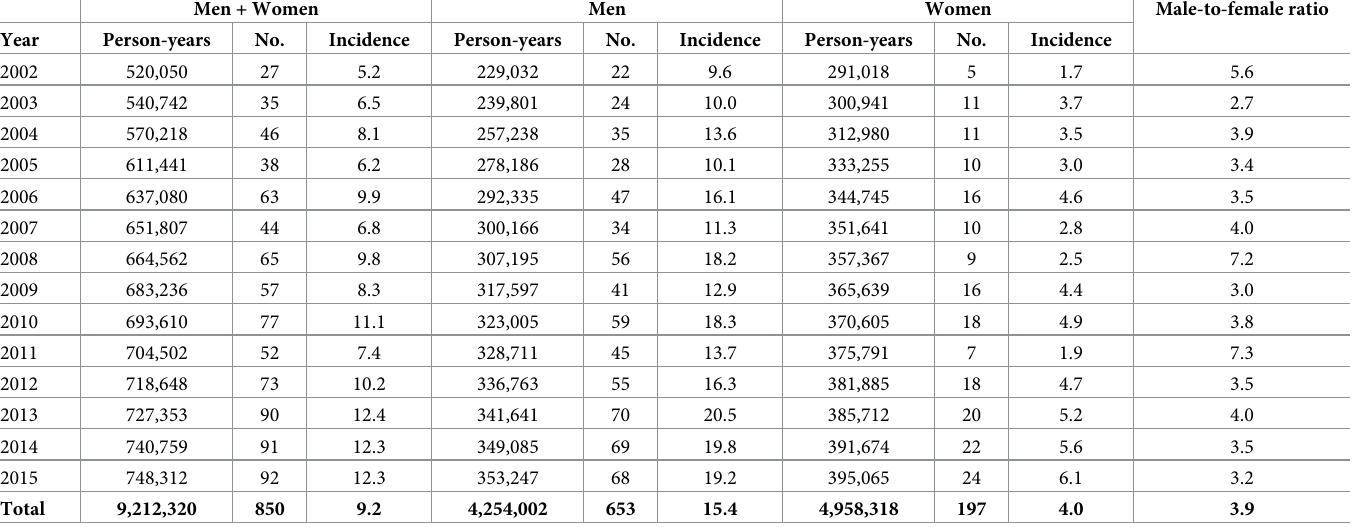
Table 1. Incidence of achilles tendon repair per 100,000 person-years, listed annually. Men +